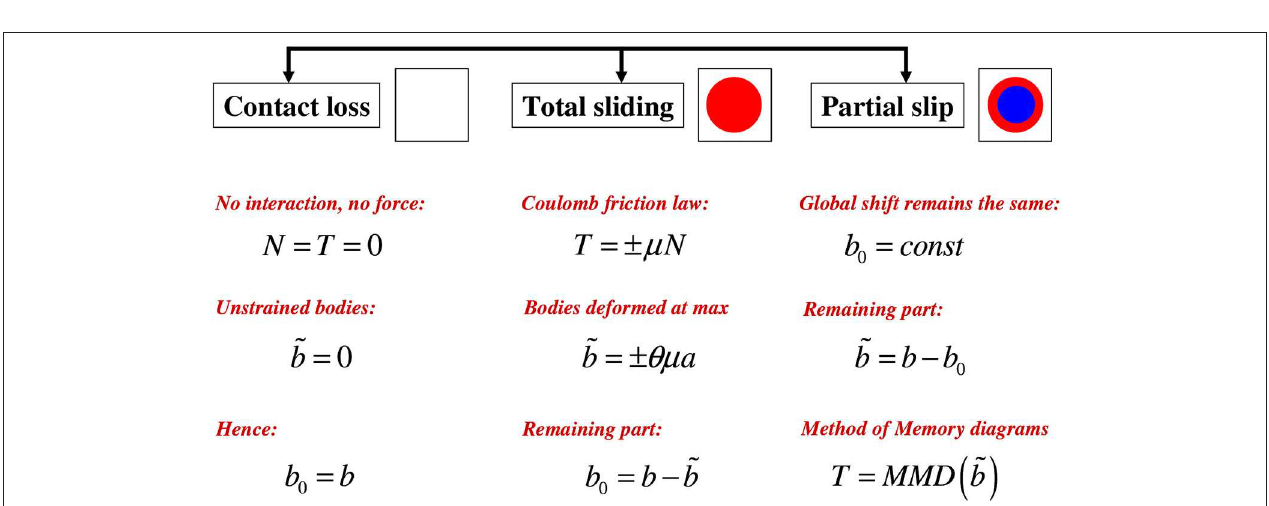
FIGURE 4 | Three contact states (contact loss, total sliding, and partial slip) and the corresponding solutions for T obtained via repartition b = b 0 + ˜ b for loading in 2D (normal and tangential displacements always stay in one plane).